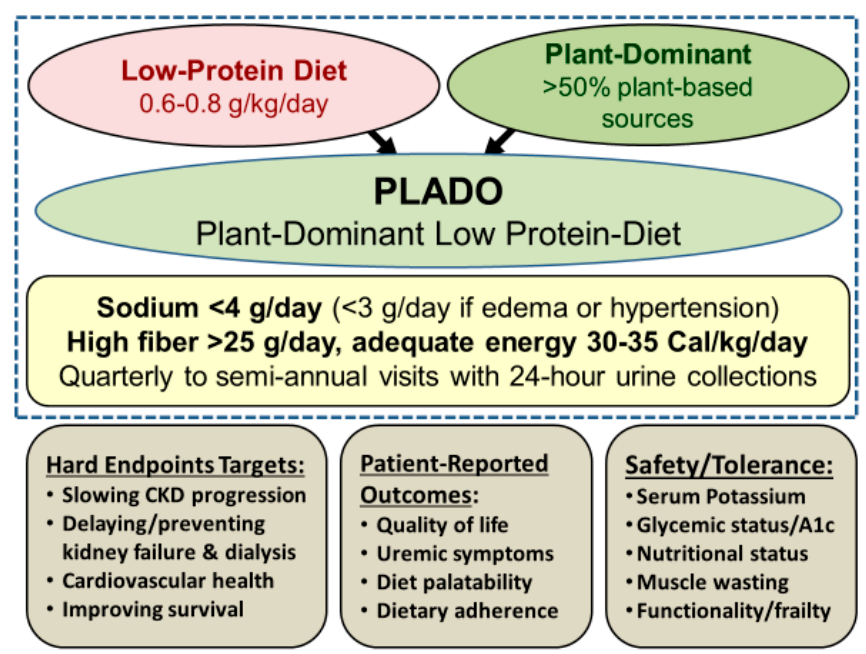
Figure 3. Overview of the plant-dominant low-protein diet (PLADO) for nutritional management of CKD, based on a total dietary intake of 0.6–0.8 g / kg / day with > 50% plant-based sources, preferentially unprocessed foods, relatively low dietary sodium intake < 3 g / day (but the patient can target to avoid > 4 g / day if no edema occurs with well controlled hypertension), higher dietary fiber of at least 25–30 g / day, and adequate dietary energy intake of 30–35 Cal / kg / day. Weight is based on the ideal body weight. Note that serum B12 should be monitored after three years of vegan dieting.